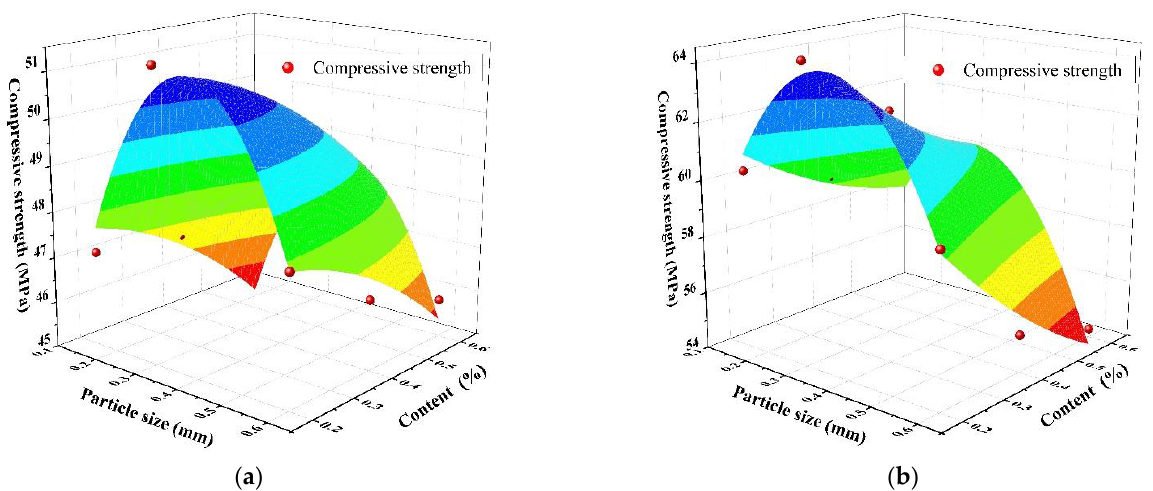
Figure 4. The relationship between SAP particle size, content and compressive strength: ( a ) water–cement ratio of 0.3; ( b ) water–cement ratio of 0.37.